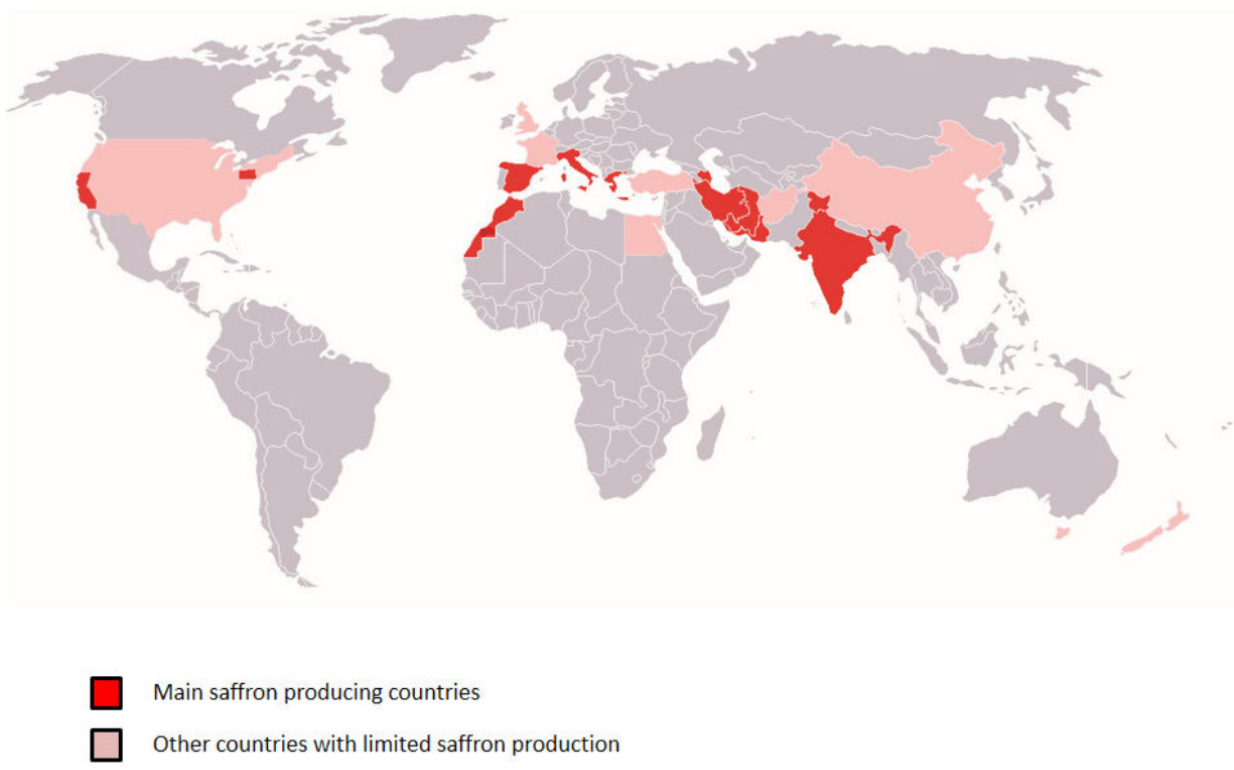
Figure 1. Main area of the culture of saffron in the world. (Realized by Nathalie Bancod (Université de Bourgogne, Dijon, France) based on the following site illustration: https://www.safranprestige.fr/histoire-du-safran/ (accessed on 28 January 2022)).